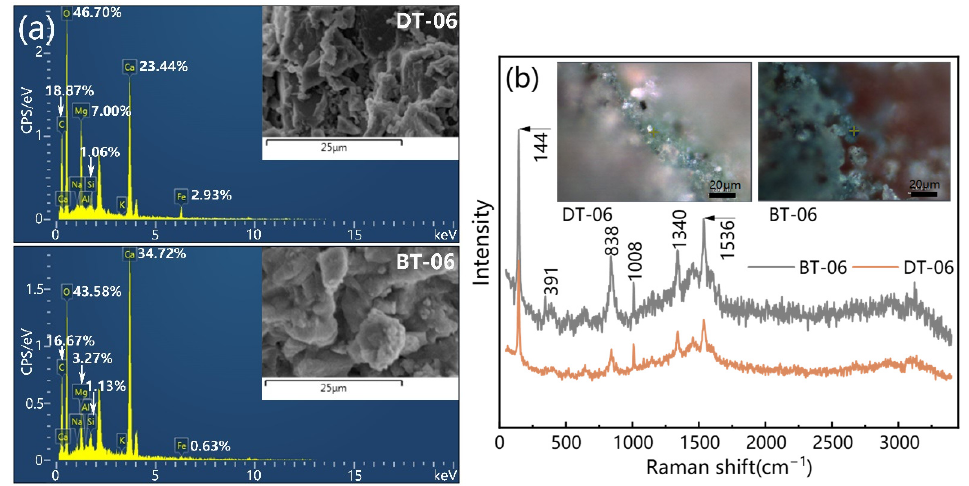
Figure 9. ( a ) Elemental analysis by SEM-EDS and ( b ) Raman spectra for the dark green samples (DT-06 and BT-06).